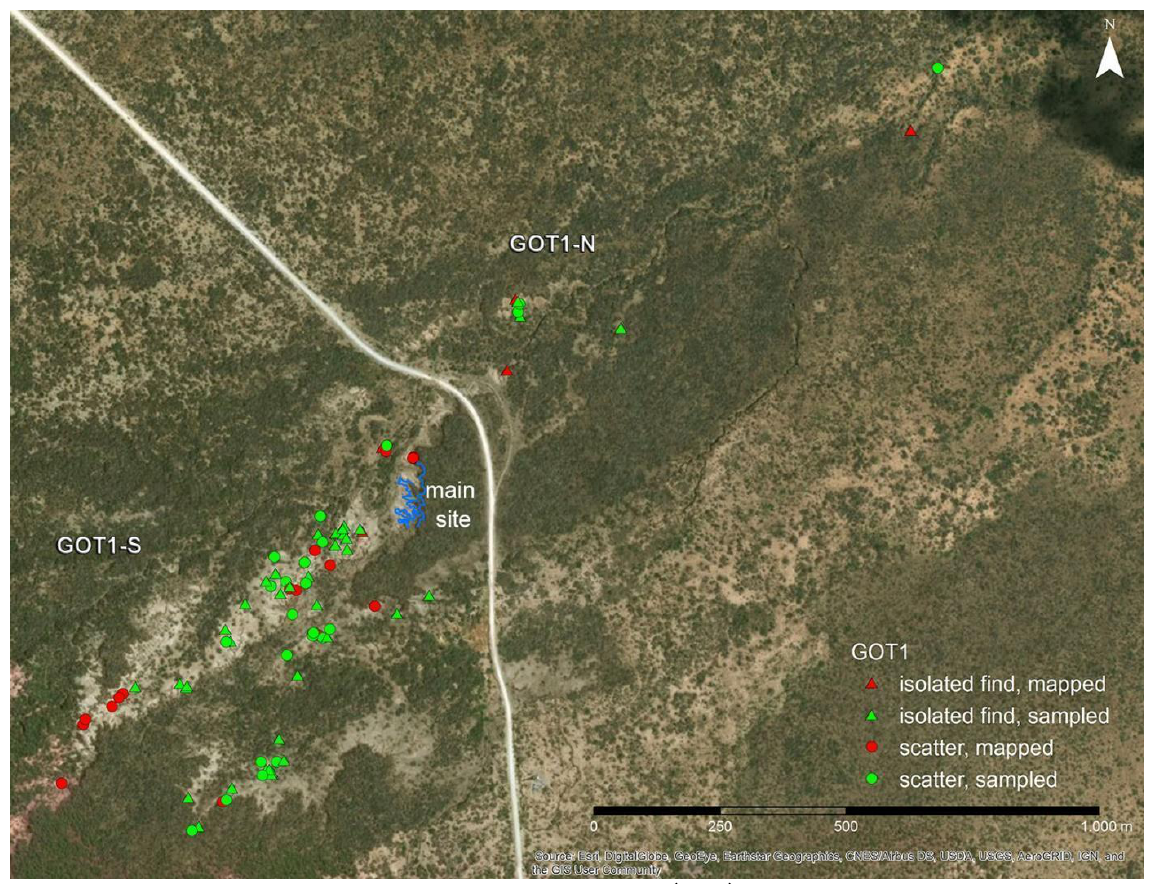
Figure 4. Detail of Gotera area with main sites and surveyed area (2017). Map data: Google